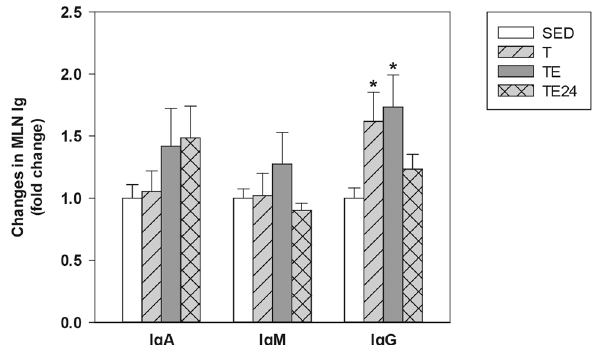
Figure 7. Changes in the IgA ( a ), IgM ( b ) and IgG ( c ) concentration in mesenteric lymph node lymphocyte supernatants compared to the sedentary group. SED sedentary rats, T trained rats, TE T rats with a